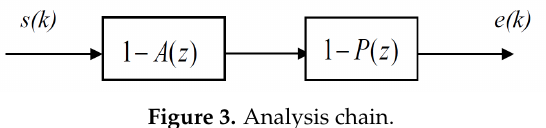
Figure 3. Analysis